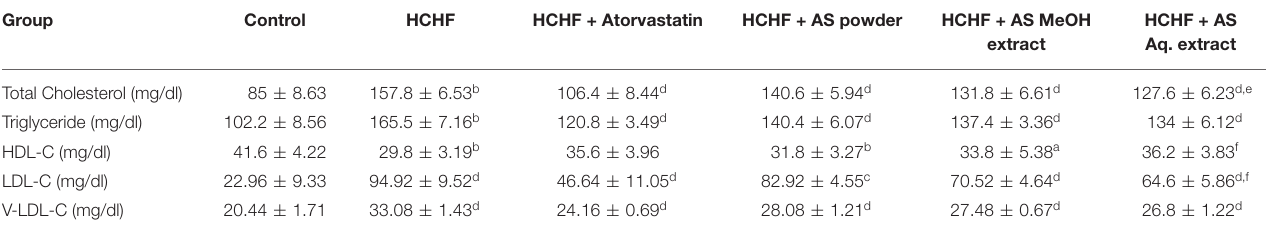
TABLE 2 | Effect of Amaranthus spinosus on serum lipid profile. Group Control HCHF HCHF + Atorvastatin HCHF + AS powder HCHF + AS MeOH HCHF + AS Total Cholesterol (mg/dl) 85 ± 8.63 Triglyceride (mg/dl)